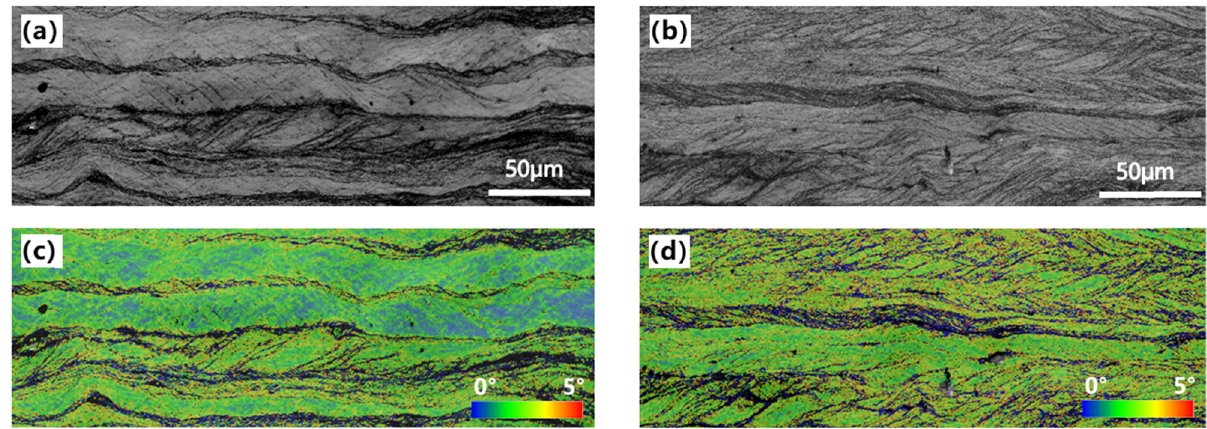
Figure 16: Microstructure of cold - rolled sheet and its corresponding KAM distribution diagram: ( a and c ) Y - free and ( b and d ) Y - bearing.